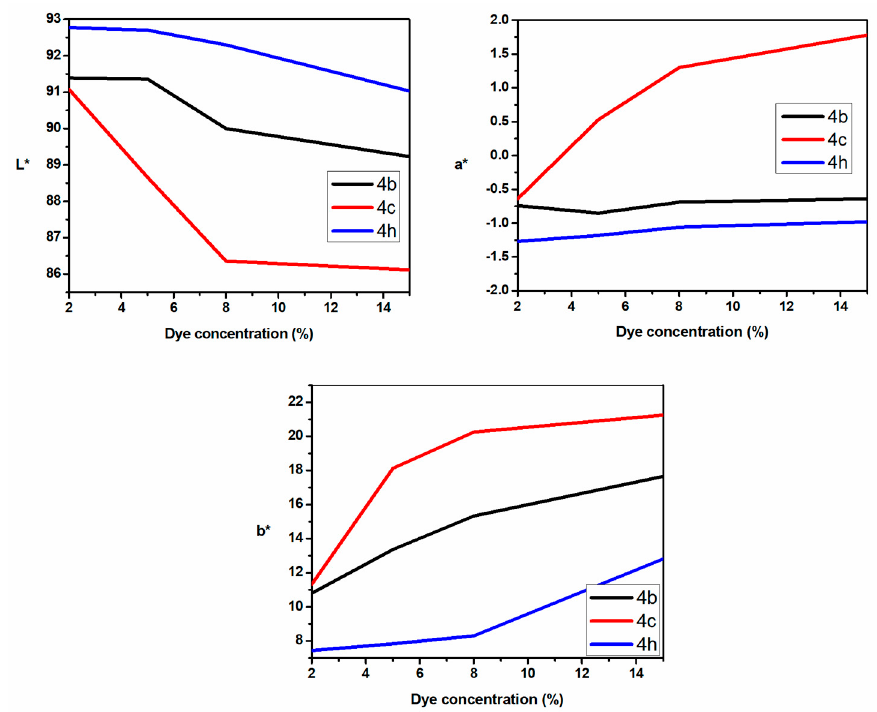
Figure 4. The dependence of CIEL*a*b* parameters on the dye concentration for dyes 4b , 4c , and 4h . The highest value for the luminosity appears for dye 4h . The parameter a* is in the red domain for dye 4c , and in the light green domain for dyes 4b and 4h . At the same time, the parameter b* has higher values in the yellow domain for dye 4c , and lower values, also in the yellow domain, for dyes 4b and 4h ,